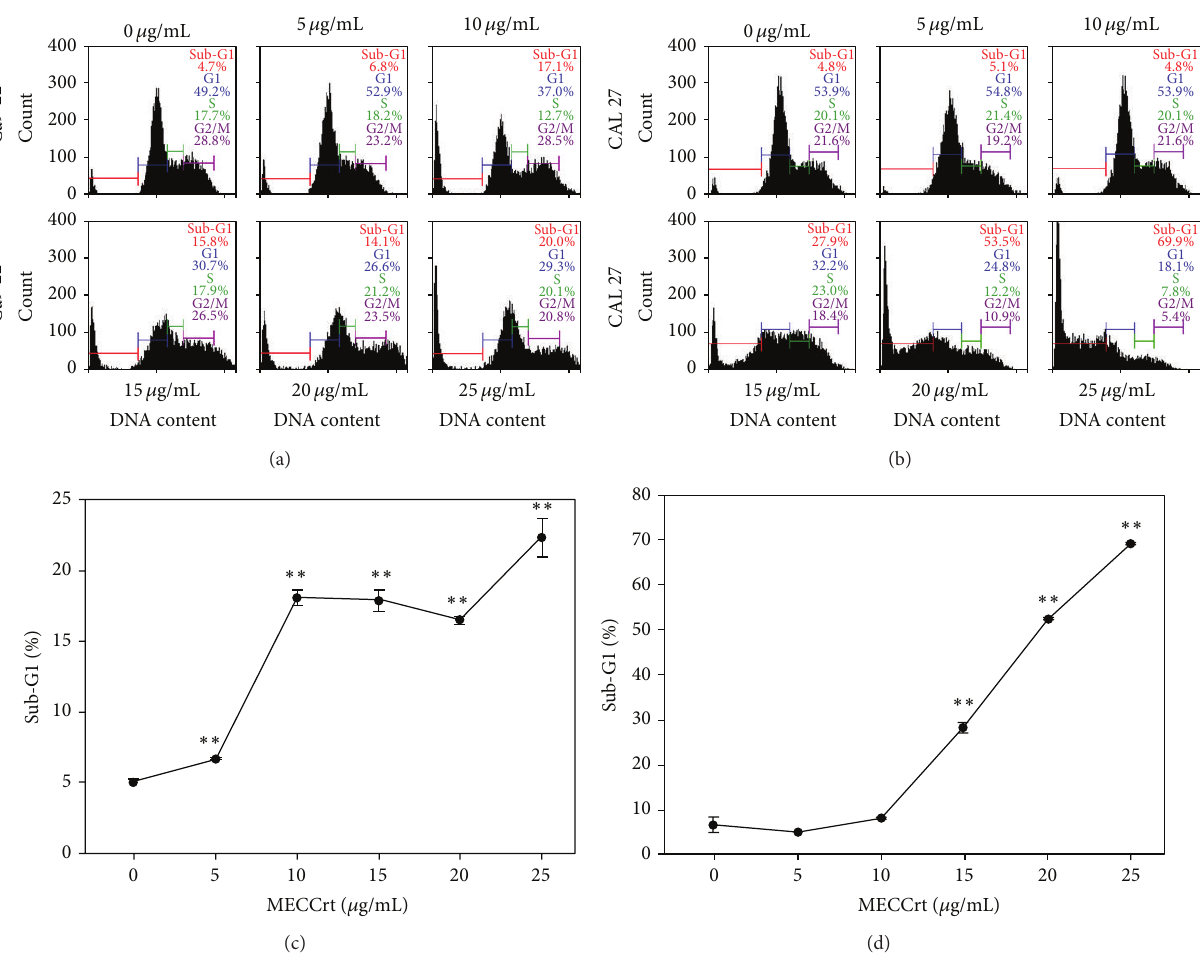
Figure 2: The sub-G1 accumulation of two oral cancer cells was induced by MECCrt. Oral cancer Ca9-22 and CAL 27 cell lines were treated with 0, 5, 10, 15, 20, and 25 𝜇 g/mL of MECCrt for 24 h. ((a) and (b)) Representative cell cycle distribution profiles of flow cytometry for MECCrt-treated oral cancer Ca9-22 and CAL 27 cells and vehicles at 24h, respectively. ((c) and (d)) Statistics analyses for the percentages of sub-G1 population in (a) and (b), respectively. Data, means ± SDs ( 𝑛 = 3 ). ∗∗ 𝑃 < 0.01 against